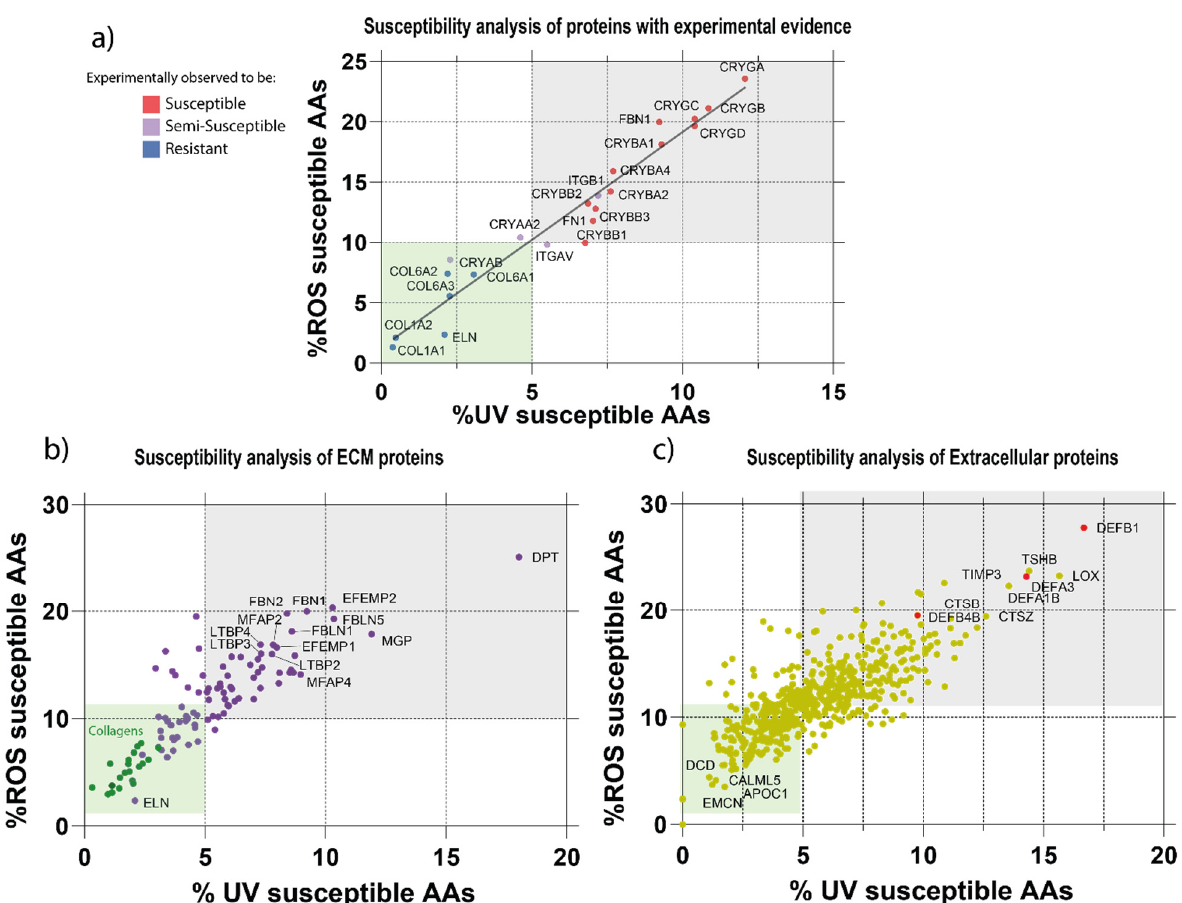
Figure 3. Predicted susceptibilities of skin proteins to photo- and oxidative-damage based on amino acid (AA) composition. ( a ) Predicted ultraviolet radiation (UVR) and/or ROS susceptibilities of proteins previously reported as susceptible or resistant by experimental observation. Experimentally verified UVR and ROS susceptible proteins (red) are enriched in UVR- and ROS-susceptible moieties compared with resistant proteins (blue). The predicted UVR- and ROS-susceptibilities exhibited a positive linear correlation (R 2 = 0.94). Applying thresholds to distinguish between experimentally susceptible and resistant proteins suggests that a composition of >5% UVR AA residues and >10% oxidation-sensitive AA residues may be indicative of UV/ROS susceptibility (susceptible = gray box, resistant = green box). ( b ) Predicted UVR- and ROS-susceptibilities of skin’s ECM proteins. Elastic fiber-associated proteins, except for elastin itself, and collagens (green) clearly stratify into susceptible and resistant risk categories, respectively. ( c ) Predicted UVR and ROS susceptibility of non- ECM extracellular proteins. Defensins (red) are highlighted as an example of a susceptible protein family.